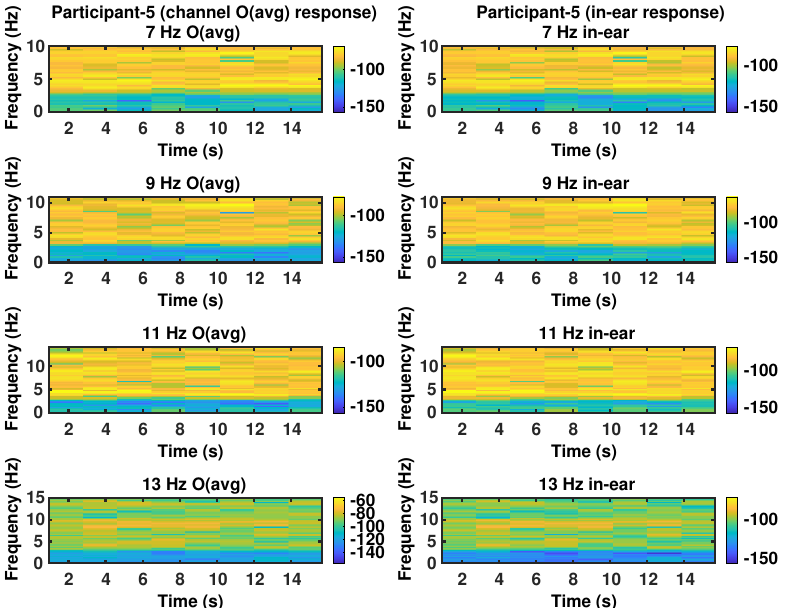
Figure 11. Spectrogram of participant 5 from occipital and in-ear